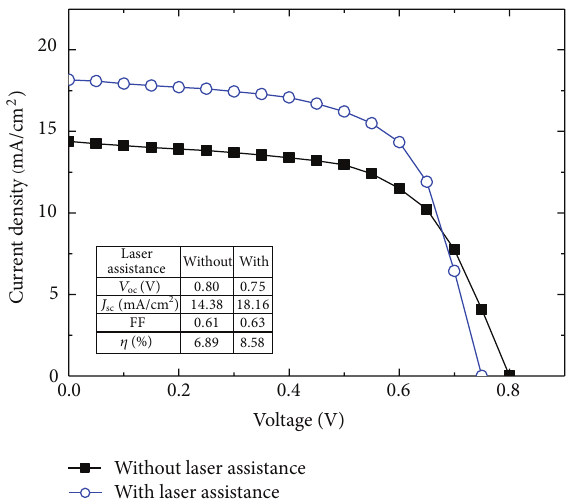
Figure 7: Current density-voltage characteristics of the p-SiC/i- Si/n-Si thin film solar cells deposited without and with assisting laser power of 80 W. The inset table shows the 𝑉 the p-SiC/i-Si/n-Si thin film solar cells deposited without and with assisting laser power of 80